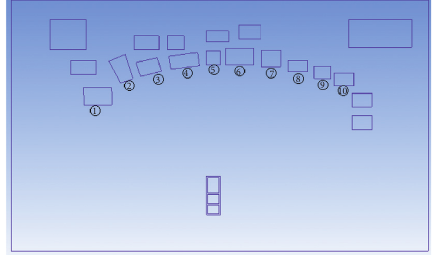
Figure 2: The geometric model.